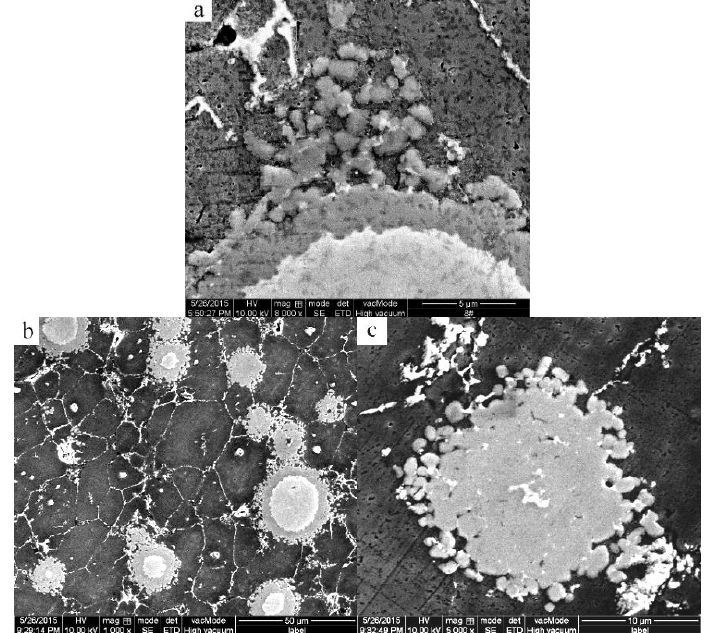
Figure 12. High magnification SEM micrographs of the mixed powder bulk heated at 640 °C for ( a ) 90 min; ( b ) 210 min; ( c ) 210 min. Materials 2016 , 9 , 199